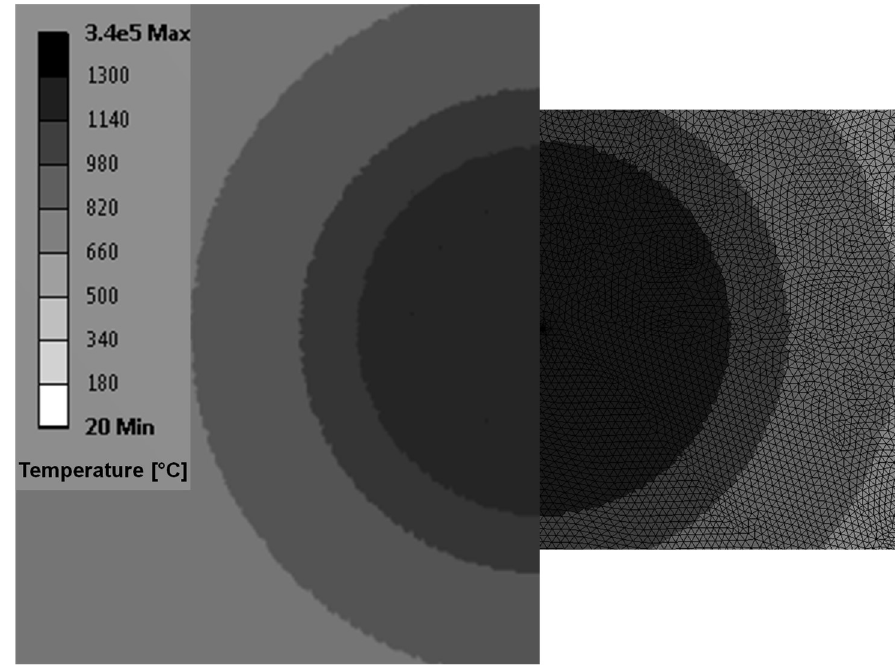
Figure 2. Mesh discretization and melt pool computation with the semi-spherical interface for a large time of 10,000 s, i.e., the steady-state has been reached. The numerical software employed is ANSYS [38].